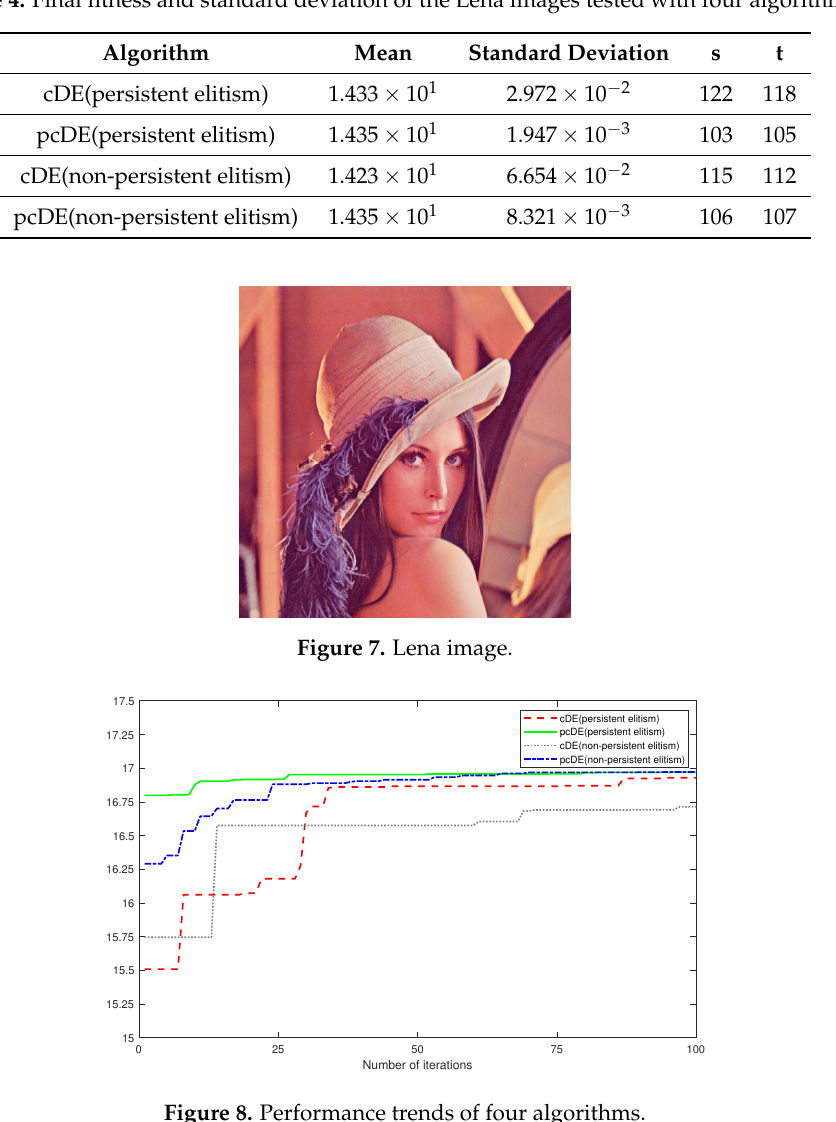
Figure 8. Performance trends of four